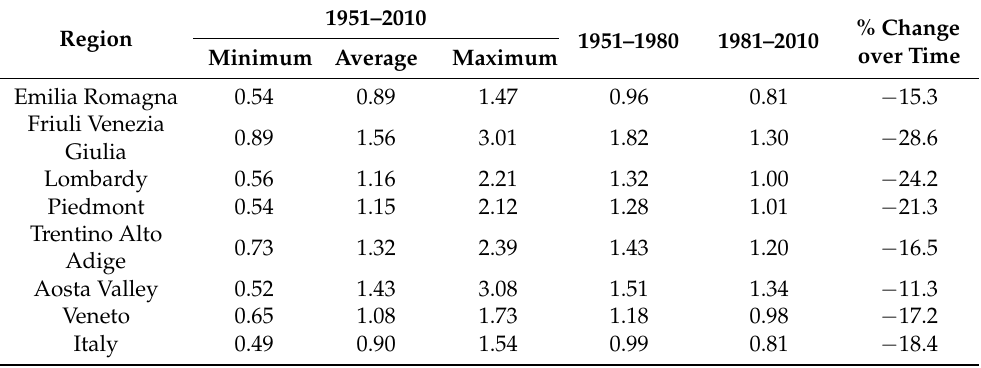
Table 1. Descriptive statistics of the climate aridity index (sensu the United Nations Environmental Program (UNEP)) by selected region (Northern Italy) over 60 years (1951–2010) and the average values for two separate time intervals covering 30 years each (an aridity index < 0.75 indicates a dry subhumid climatic condition, typical of Mediterranean temperate